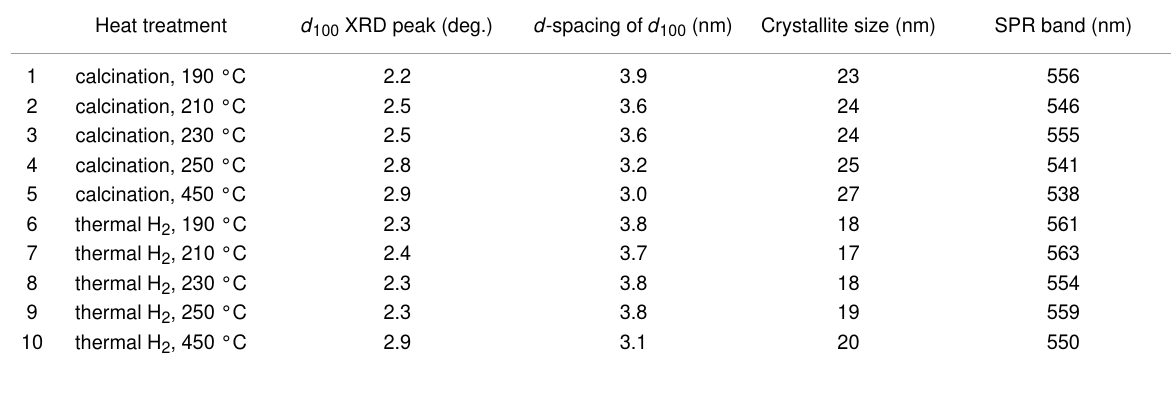
Table 1: Summary of the d 100 XRD peaks, d -spacing of mesoporous silica, the crystallite size based on calculations using Scherrer’s equation, and the surface plasmon resonance (SPR) peak maxima of the AuNPs after both types of heat treatments. Heat treatment d 100 XRD peak